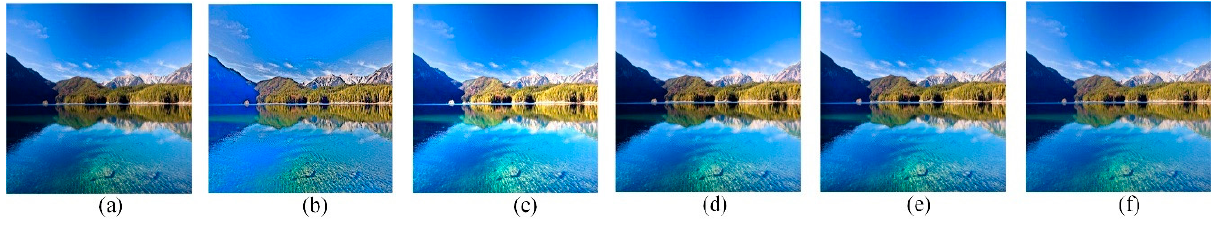
Figure 23. Landscape image. ( a ) Original image; ( b ) result of Lee’s method; ( c ) result of LIME; ( d ) result of AGCWD; ( e ) result of SIRE; ( f ) result of the proposed method.